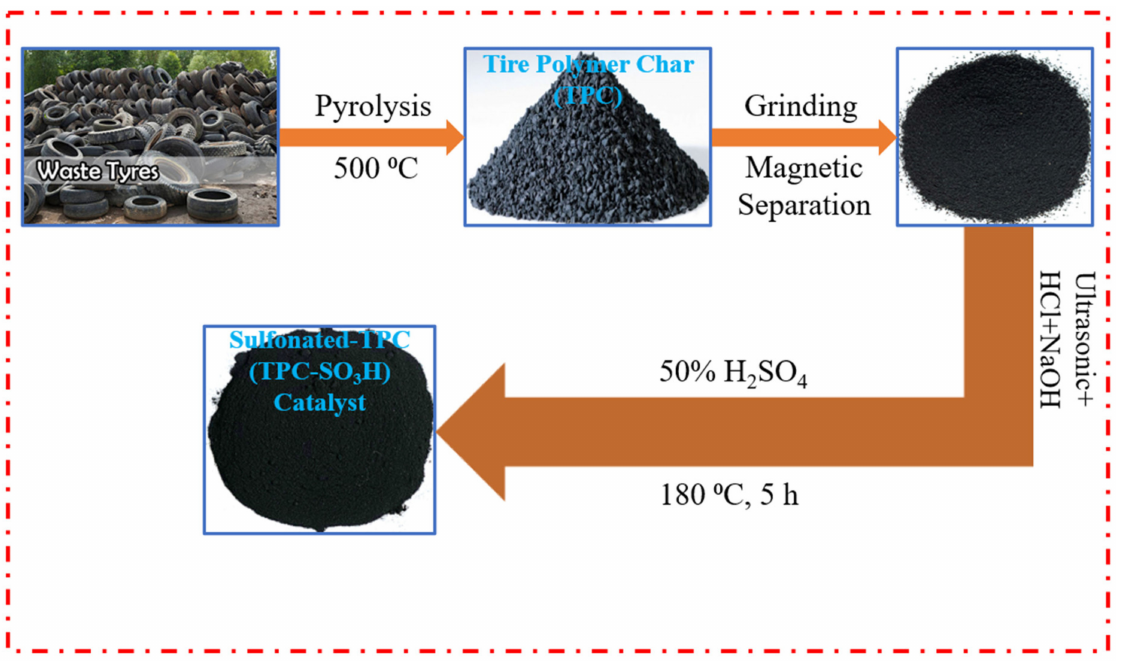
Figure 1. Sulfonated tire polymer char (TPC-SO 3 H) catalyst synthesis from tire polymer waste